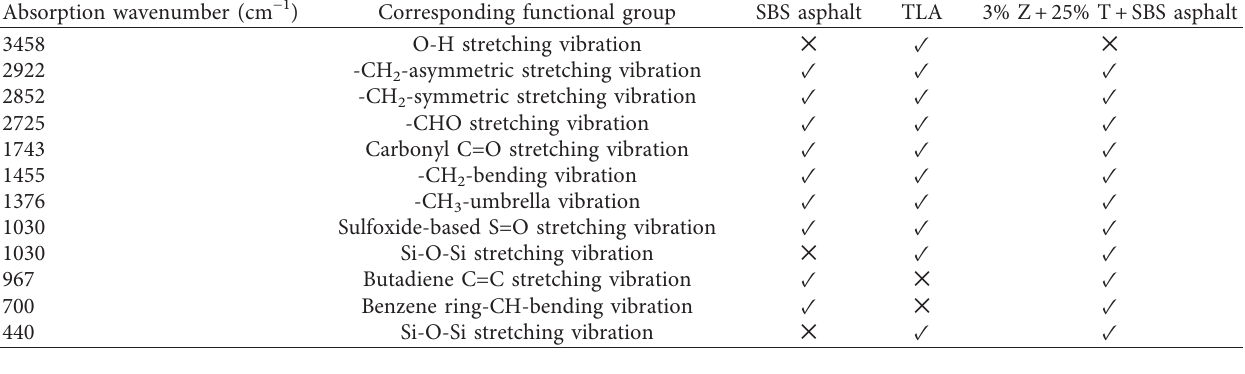
Table 5: Asphalt functional group results.